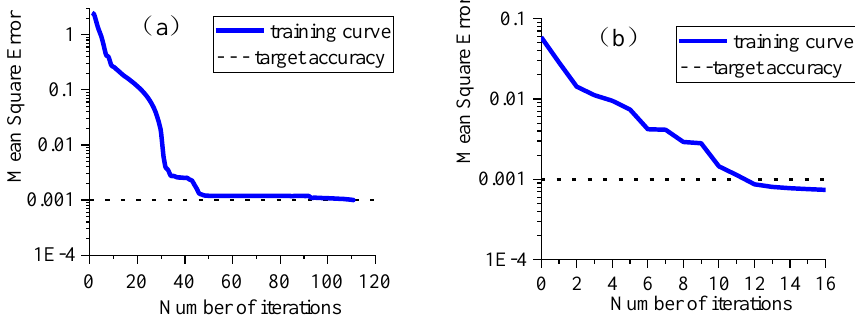
under the given conditions, and the BP neural network model needed 110 steps to reach the accuracy requirement. The RBF neural network model required only 12 steps to achieve the same condition, and its training speed was significantly better than that of the BP neural network. The above analysis shows that the RBF neural network has more advantages over the BP neural network in the training speed.